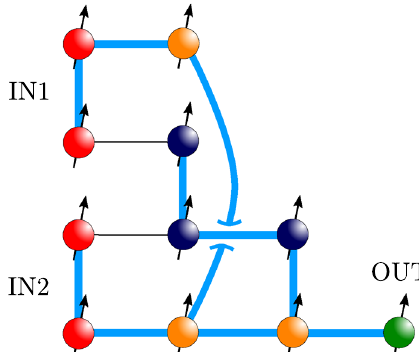
Fig. 3 Bell-state comparison network. Schematic depiction of network for comparing pairs of Bell states. The left-most layer marked in red constitute the inputs to the network, with subsequent layers extracting and comparing information about either the phase (blue) or the excitation parity (orange) of the input states, with the result of the comparison stored in the green output